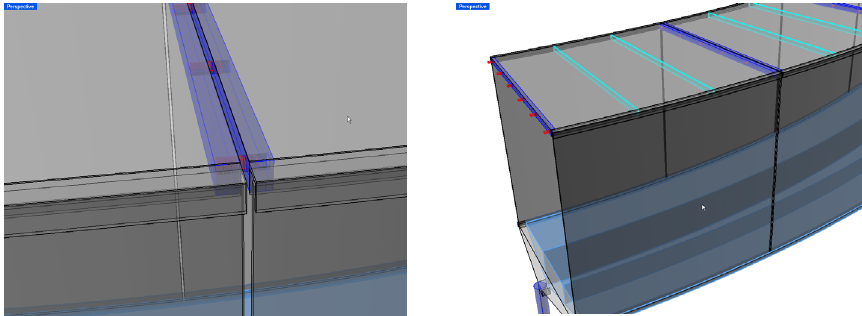
Figure 5: First concept of decoupling: extension/compression joints in the roof could be one method to exclude the roof and glass walls from forces out of bending. Therefore we tried to decouple the glass walls with soft connections of the panes to the roof plate and box girder (see Figs. 6 and 10). This soft connection - soft against relative movements between the glass panes and the steel parts - also can decouple the roof and